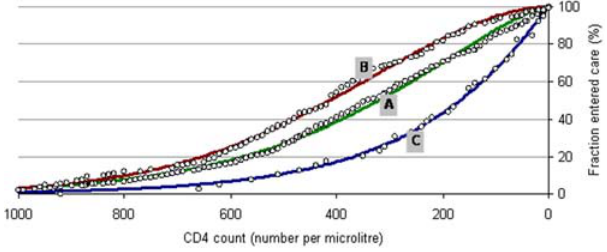
Figure 1. Distribution of CD4 count at presentation in three hospitals. Dots show data and lines show fitted Weibull curves with shape ( a ) and scale ( b ) parameters as follows: Hospital A a =1.43 b =414.46; Hospital B a =1.83 b =505.12; Hospital C a =1.06 b =236.45.